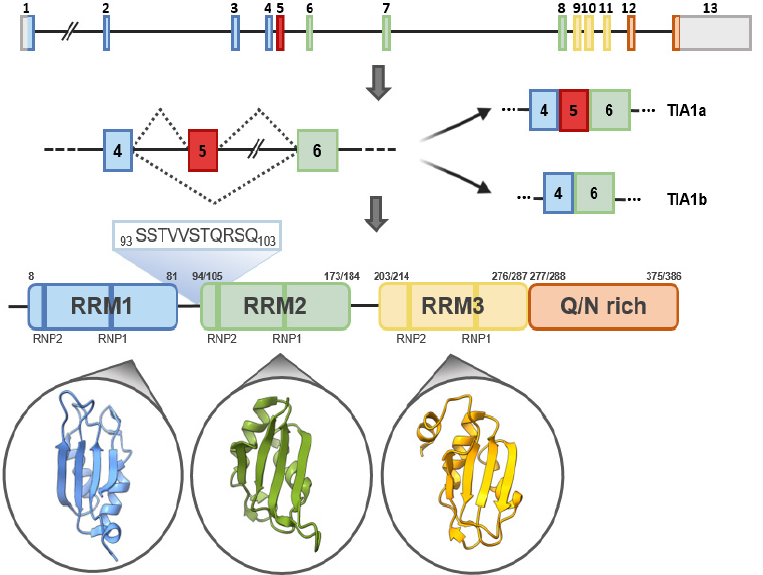
Figure 2. TIA1: gene, isoforms and protein structural details. Schematic representation of human TIA1 gene. Organization of exons and introns of the main isoforms, a and b, generated by alternative splicing, as well as of functional domains of TIA1. TIA1 contains three RNA-recognition motifs (RRMs) and an auxiliary domain rich in asparagine and glutamine (Q/N-rich domain). The amino- acid sequences that differentiate TIA1 a and b isoforms are shown in green. The secondary-tertiary structures of each of the three RRMs are highlighted in the corresponding circles. different vertebrate species, Caenorhabditis elegans and Drosophila melanogaster , illustrates